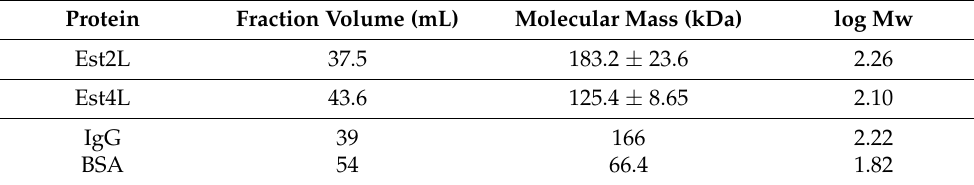
Table 2. Molecular masses of native Est2L and Est4L determined with Sephacryl S-200.